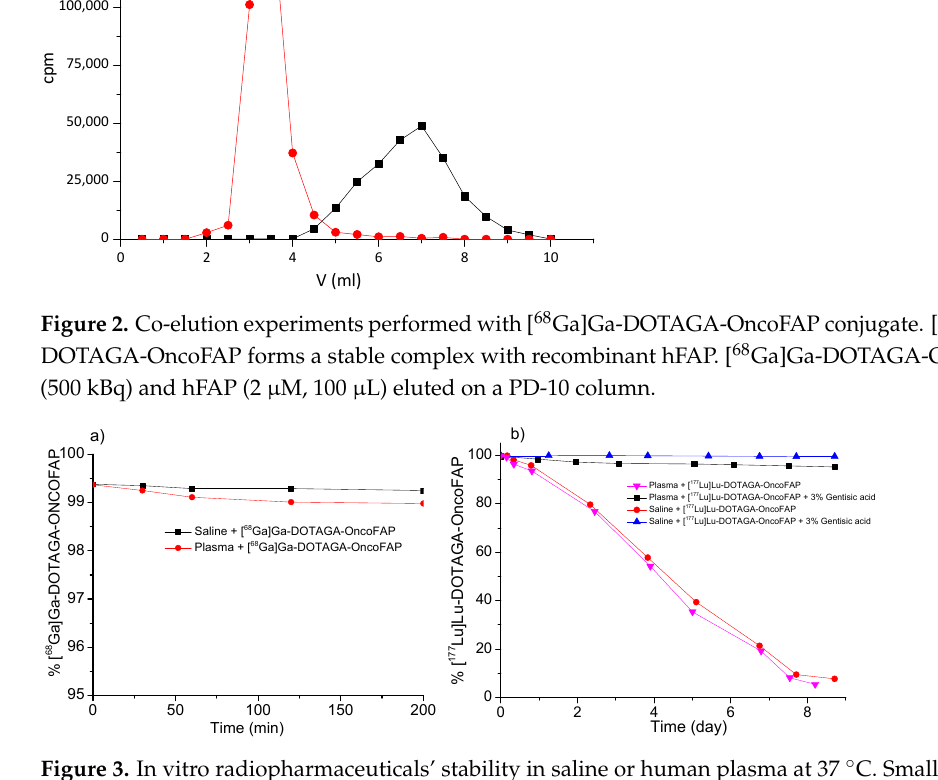
Figure 3. In vitro radiopharmaceuticals’ stability in saline or human plasma at 37 °C. Small aliquots were analyzed by HPLC ( a ) 30–60–90–120–150–180 min for [ 68 Ga]Ga-DOTAGA-OncoFAP and ( b ) 1–3–6–12–24–48–72–96 h and 7 days for [ 177 Lu]Lu-DOTAGA-OncoFAP. Cell binding studies showed a similar trend of binding on FAP-positive SK-RC-52 cells for all the OncoFAP radio-conjugates. All the compounds displayed an intense bind- ing at early time point (10 min), followed by a progressive decrease over time. As shown in Figure 4, a major difference in the absolute binding value was found among 20% for [ 177 Lu]Lu-DOTAGA-OncoFAP, 2.3% for [ 68 Ga]Ga-DOTAGA-OncoFAP and 0.25% for [ 18 F]AlF-NOTA-OncoFAP. Results of the nonspecific binding on SK-R-RC-52 wild-type (SK-RC-52.wt) showed a very low absolute binding value for all the compounds (Figure 4). Figure 4. Cell binding assays in SK-RC-52.hFAP and SK-R-RC-52 wild-type (SK-RC-52.wt) cells (density of 1.5 × 10 5 cells each tube). ( a ) [ 68 Ga]Ga-DOTAGA-OncoFAP and [ 18 F]AlF-NOTA-OncoFAP (10 µ L, 0.1 MBq) cells were incubated at 37 ◦ C for 10, 30, 60 and 120 min. ( b ) [ 177 Lu]Lu-DOTAGA-OncoFAP (10 μ L, 0.1 MBq) cells were incubated at 37 °C for 10, 120, 240, 360 min and 24 and 48 h. In vivo biodistribution of [ 18 F]AlF-NOTA-OncoFAP (500 nmol/kg, ~4 MBq/Kg, RCP 89%) in athymic Balb/c AnNRj-Foxn1 mice bearing subcutaneous HT-1080.hFAP fibrosar- coma showed selective accumulation in FAP-positive tumors (6.6% ID/g, 1 h post intrave- nous injection), with excellent selectivity against healthy organs. Tumor-to-blood and tu- mor-to-kidney ratios of 6.5-to-1 and 4.3-to-1, respectively, were observed at the 1-h time point (Figure 5).